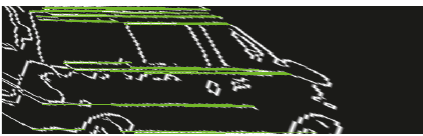
Figure 41: Extraction result of the line in the left view of van.